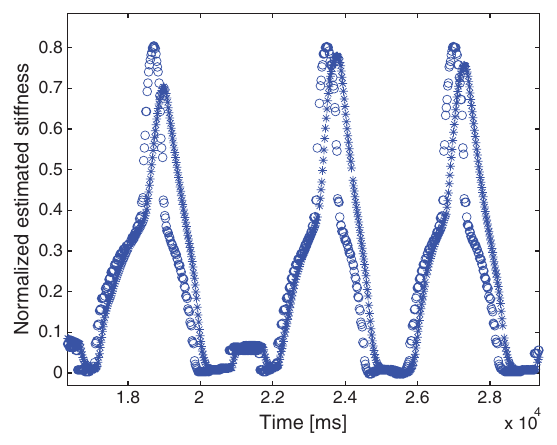
Fig. 14. The model’s punctual stiffness has been estimated with a Kalman filter. The figure presents the stiffness estimation vs. time. Real stiffness (cid:3) , Kalman filter estimated stiffness *.